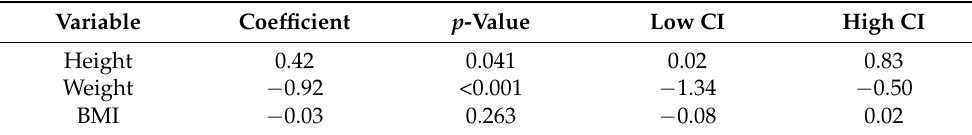
Table 6. Factors predicting changes in cholesterol levels revealed by multivariable regression